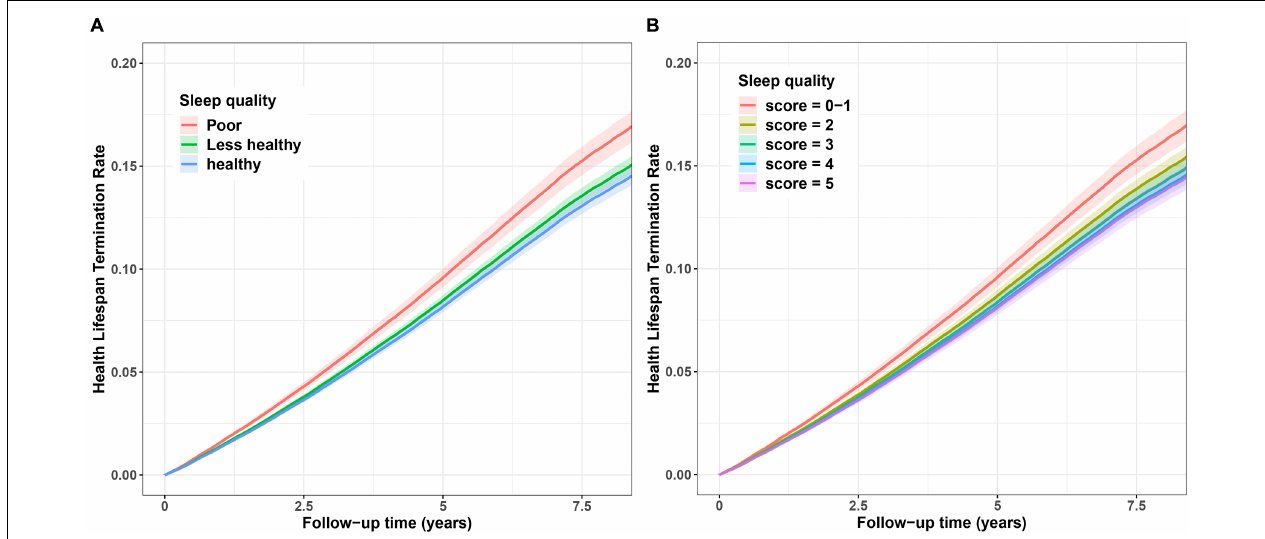
FIGURE 2 | Cumulative hazard curve for the associations between sleep quality and risk of terminated health span. (A) Sleep quality (poor, less–healthy, and healthy). (B) Sleep score (scores 0–1, 2, 3, 4, and 5). The Y -axis represents cumulative hazard of terminated health span, the while X -axis represents the follow-up time (years). Shaded regions represent the 95% confidence intervals (95% CIs). Cumulative hazard curves were based on the fully adjusted model. TABLE 3 | Associations for low-risk sleep behaviors with risk of terminated health span among 328,850 participants. Sleep behaviors Total (N) Cases (N) Basic model* Fully adjusted model